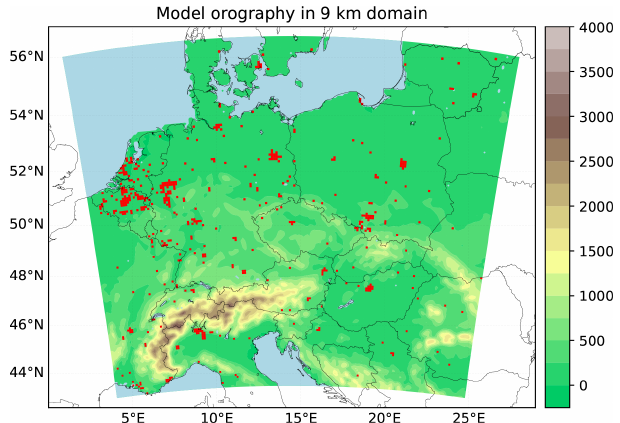
Figure 1. Position of model domain with model orography (m) and grid boxes marked with red, in which the urban land-use type is dominant.